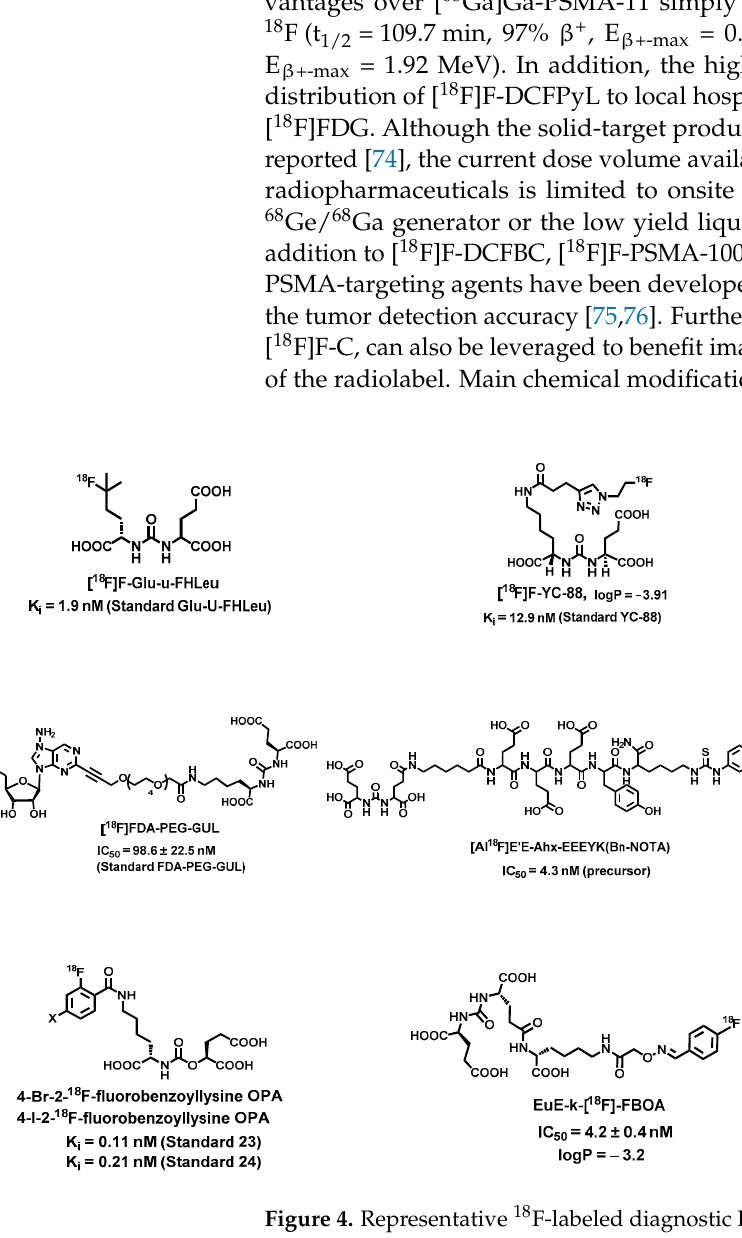
Figure 4. Representative 18 F-labeled diagnostic PSMA-targeting ligands